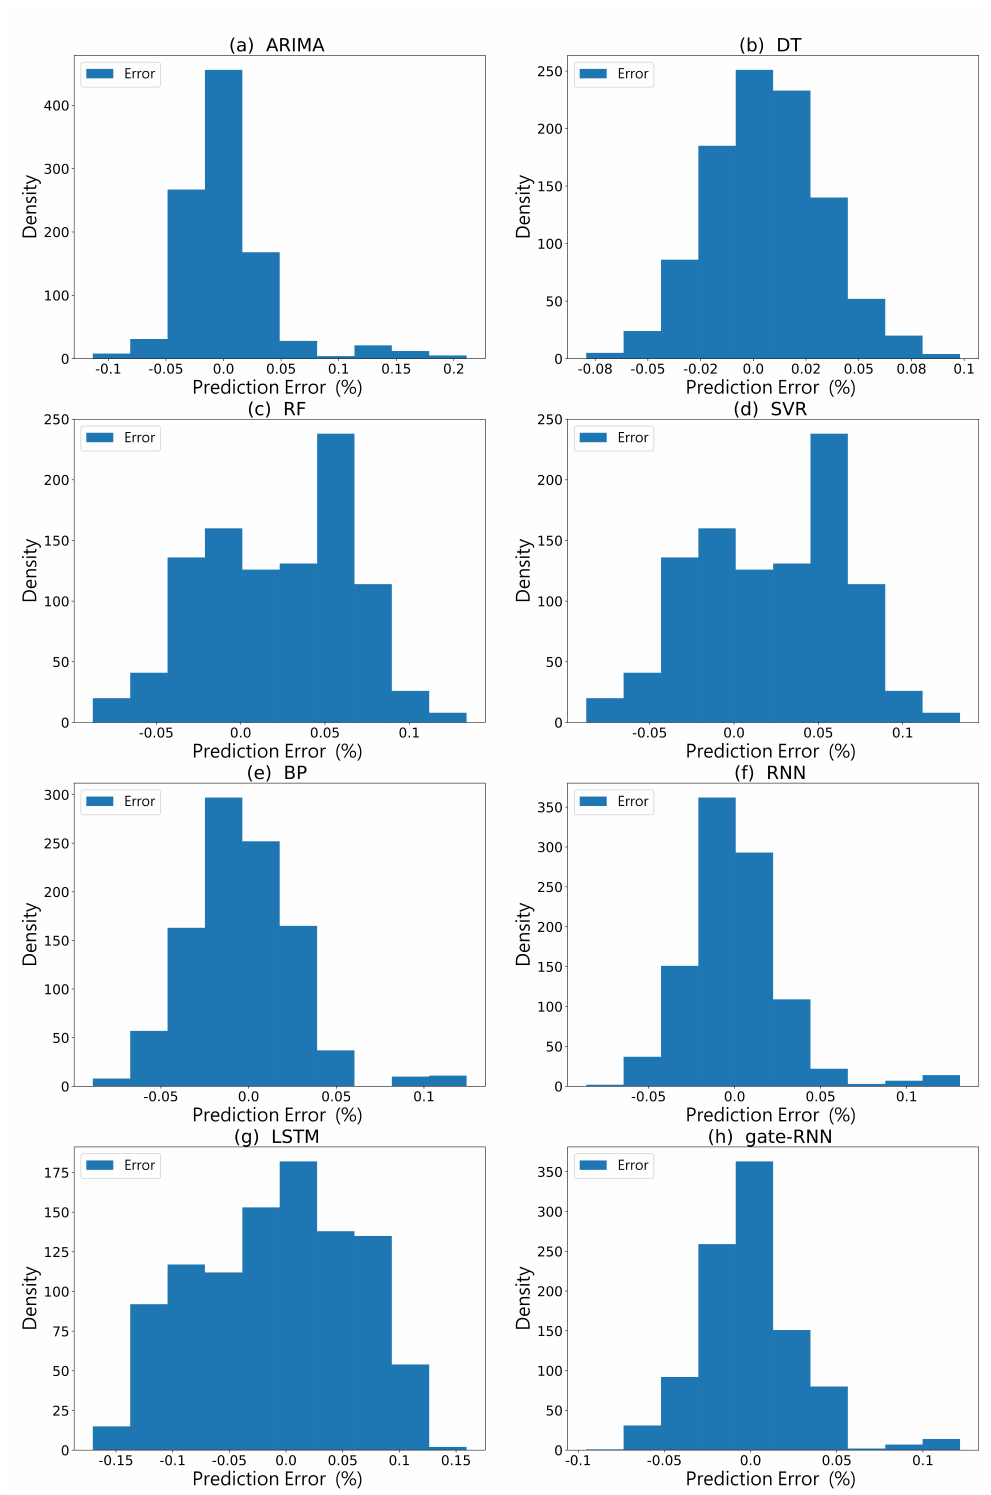
Figure 11. All eight methods’ prediction error distributions in 30-min time scale. ( a ) distribution of ARIMA; ( b ) distribution of DT; ( c ) distribution of RF; ( d ) distribution of SVR; ( e ) distribution of BP; ( f ) distribution of RNN; ( g ) distribution of LSTM; ( h ) distribution of